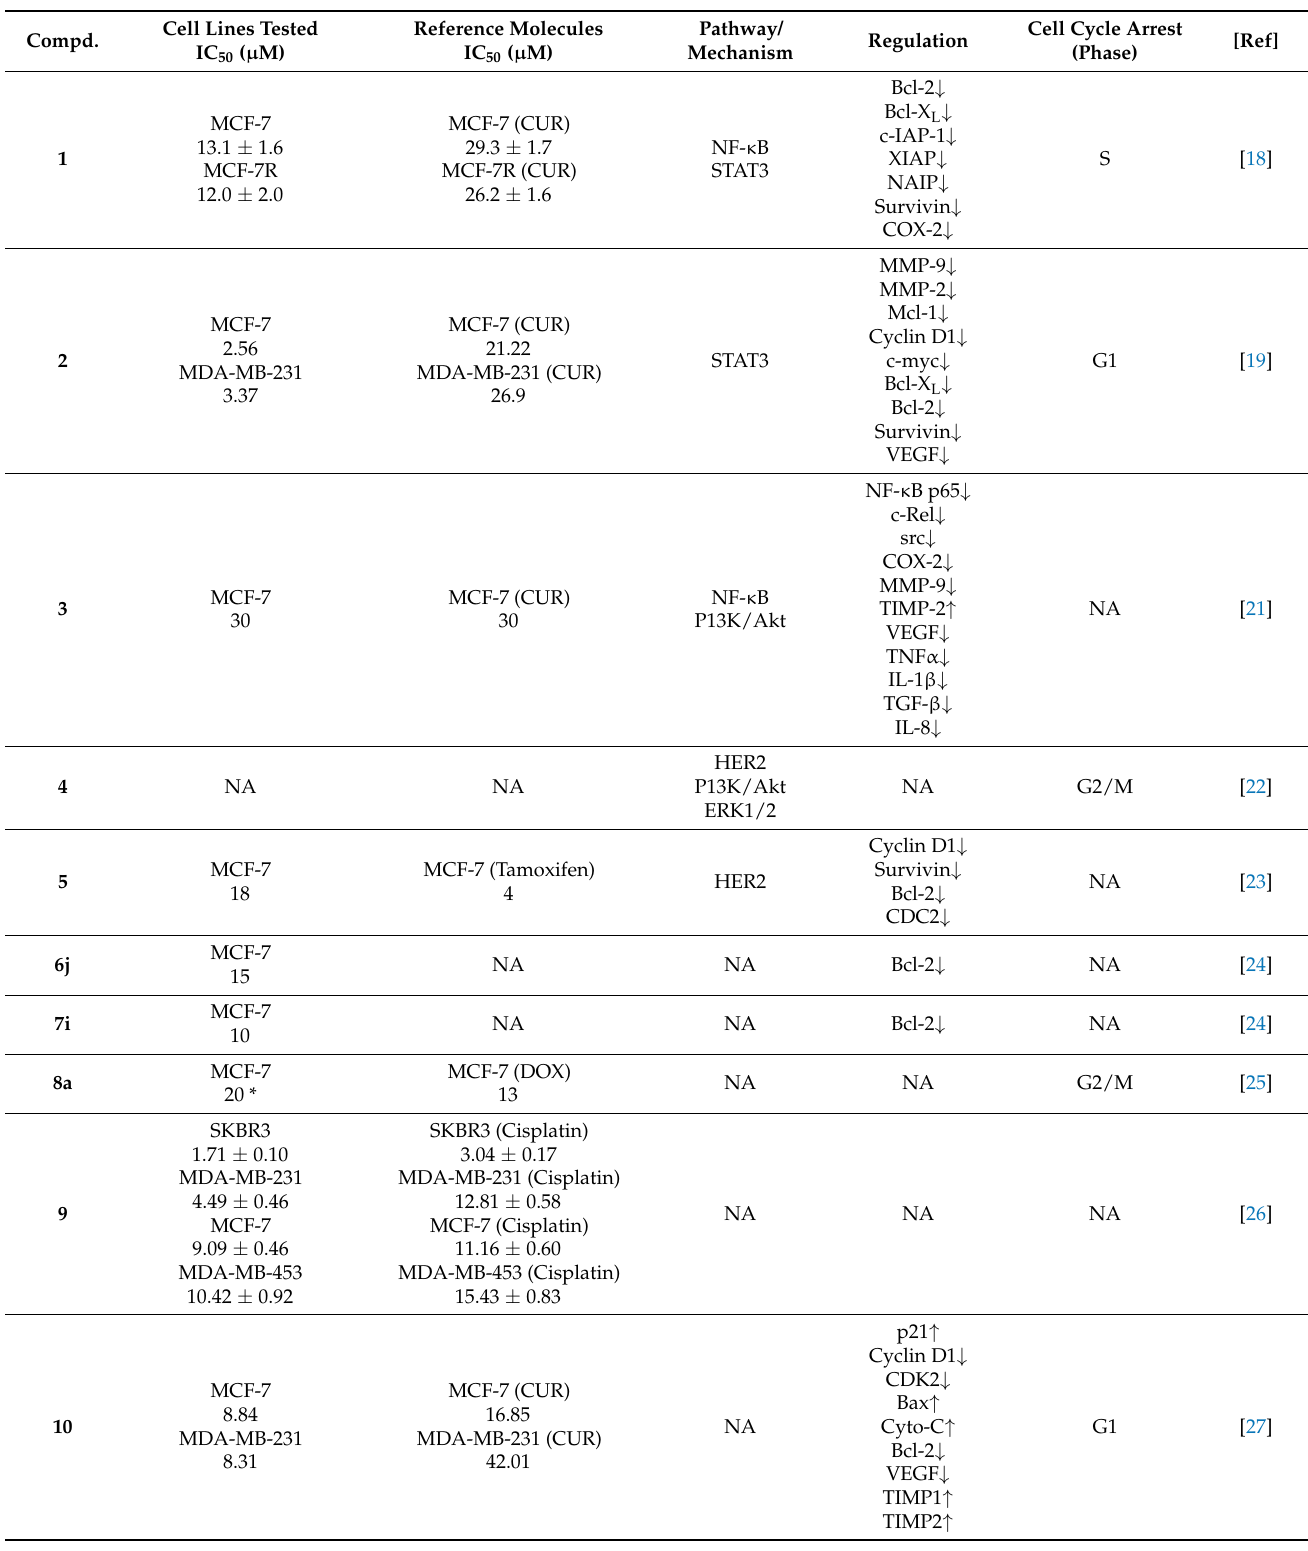
Table 1. Summarized information on curcumin analogs.